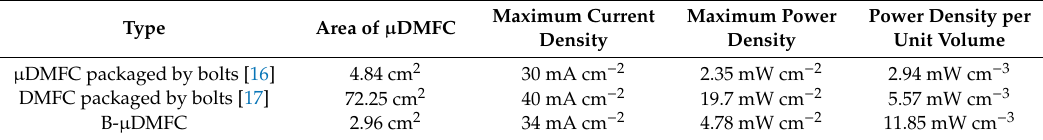
Table 2. Comparison of B- µ DMFC and other two µ DMFC performance